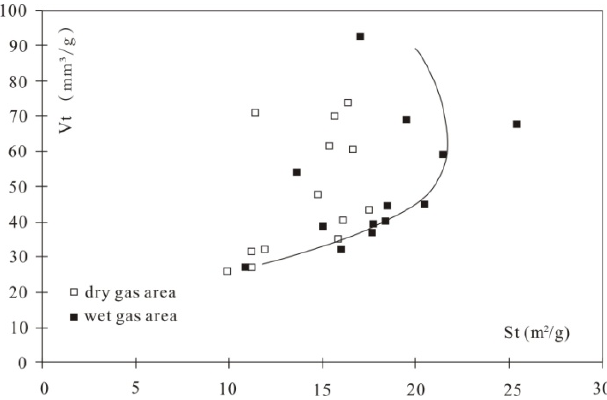
Figure 6. Relationship between total pore volume and pore surface area (Lan et al., 2020).